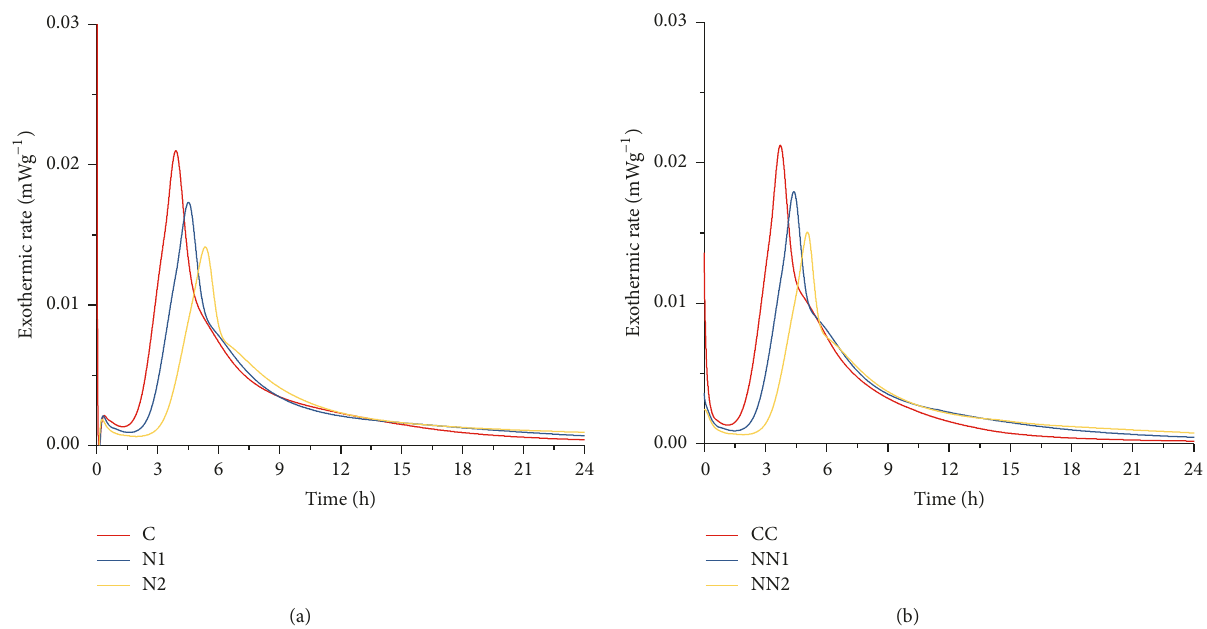
Figure 4: (a) Exothermic rates during the hydration of samples C, N1, and N2 at 60 ∘ C. (b) Exothermic rates during the hydration of samples CC, NN1, and NN2 at 60 ∘ C.